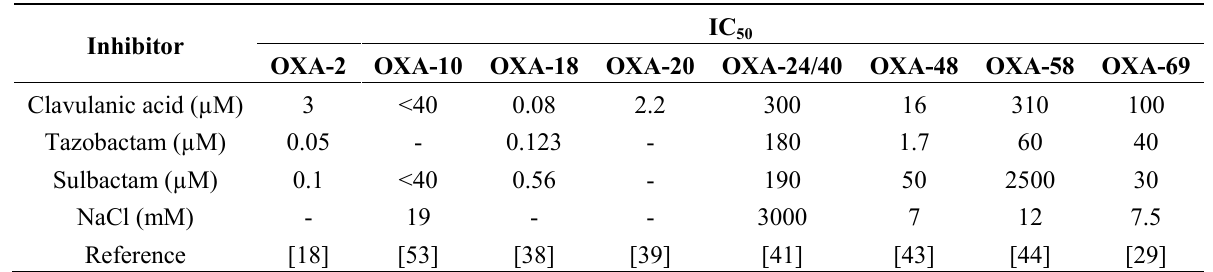
Table 6. IC values for selected 50